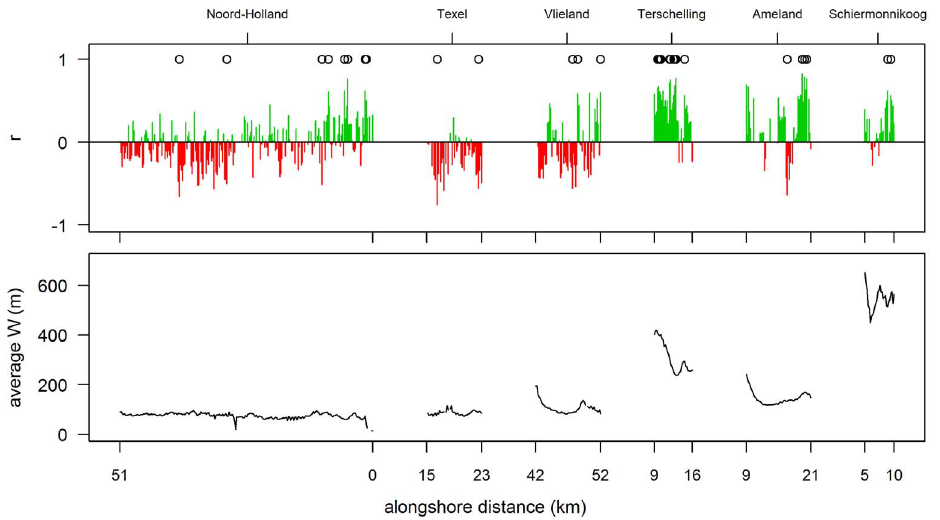
Figure 9. Correlation between time-series of dune-volume changes ( D V) and transport potential (Q). Upper panel: correlation between D V and Q, after discarding years with S . 2.5 m. Correlation was calculated as the Pearson product-moment coefficient r. Correlations significant at p , 0.05 level are indicated with ‘o’. Lower panel: time-averaged beach width (W) for each profile. The numbers on the x-axis refer to the boundaries of each location.